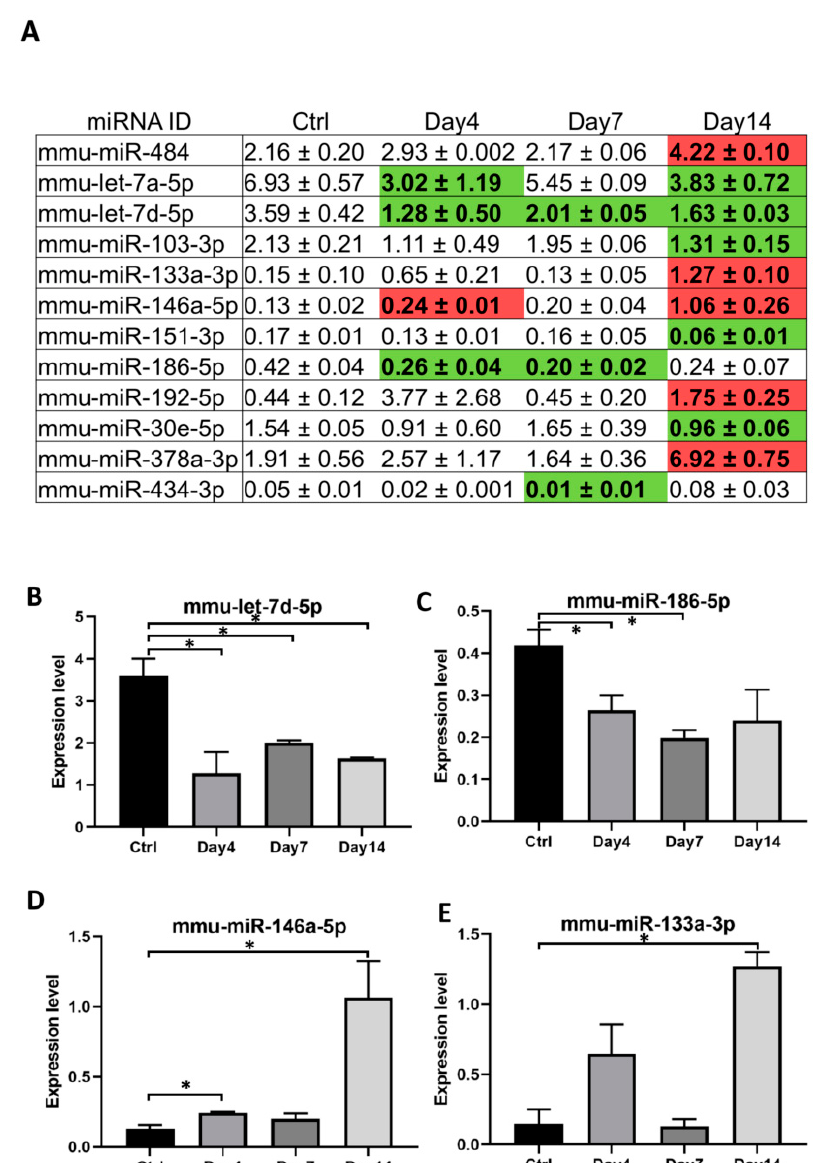
Figure 3. Abundance of serum exosomal microRNAs are regulated during O. tsutsugamushi infection. ( A ) Expression levels of thirteen miRNAs were found to be significantly regulated post infection when compared to the controls with more than 1.5 fold changes (mean ± standard deviation). Red boxes, upregulation; green boxes, downregulation. B to E, Examples of four exosomal miRNAs that were either repressed ( B , C ) or activated ( D , E ) during Orientia infection. Error bar, standard deviation from two pooled biological replicates. * p -value ≤ 0.05.